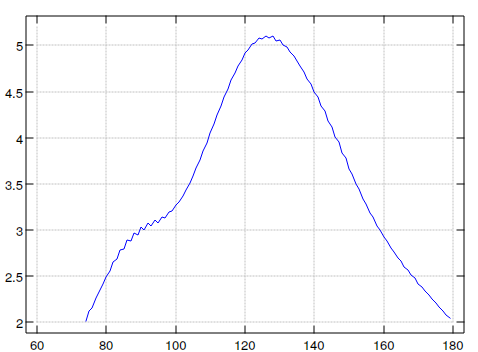
Figure 12. Current as function of time in the busiest voxel of Fig. 11, according to Ohm-Kirchhoff model